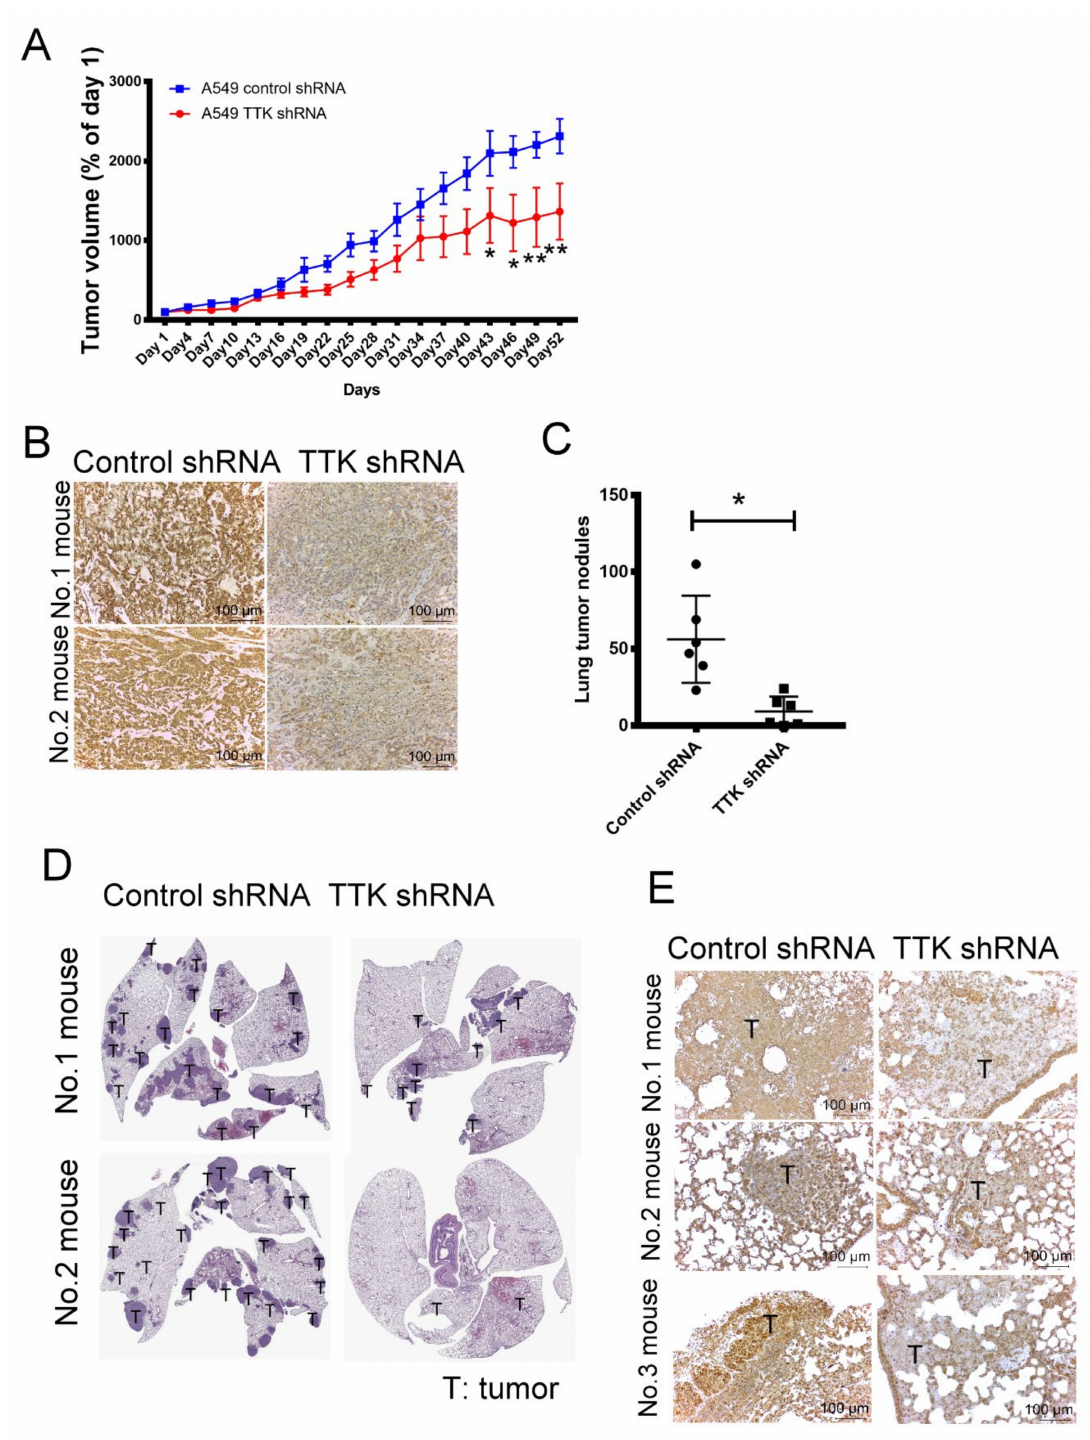
Figure 7. The e ff ect of TTK in cancer growth and metastasis in vivo. ( A ) TTK knockdown decreased tumor growth in nude mice. ( B ) The level of TTK in A549 tumor of mice. Control shRNA and TTK shRNA plasmid transfected A549 cells were administered subcutaneously into the right flank of nude mice. The tumor volume was measured every 3 days. Fifty-three days after the tumor